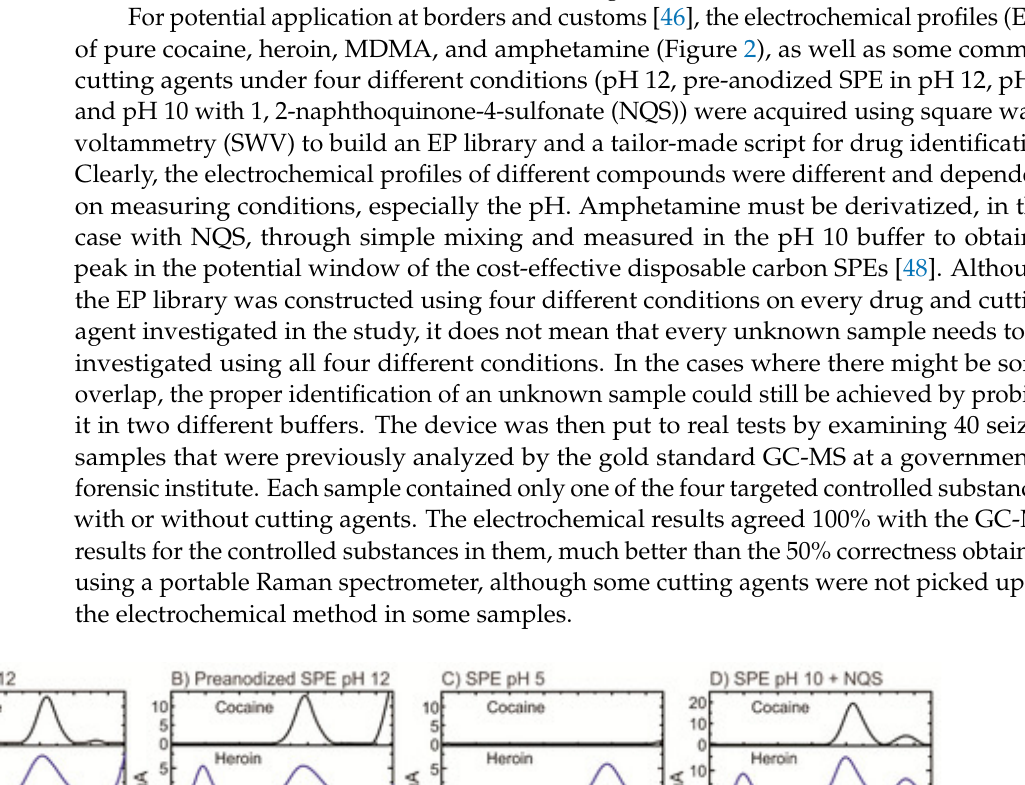
Figure 1. A portable electrochemical device for on-site detection of illicit drugs. The deposition of the solution on its connected SPE is shown [46]. Adapted from MDPI under a Creative Common CC BY license.